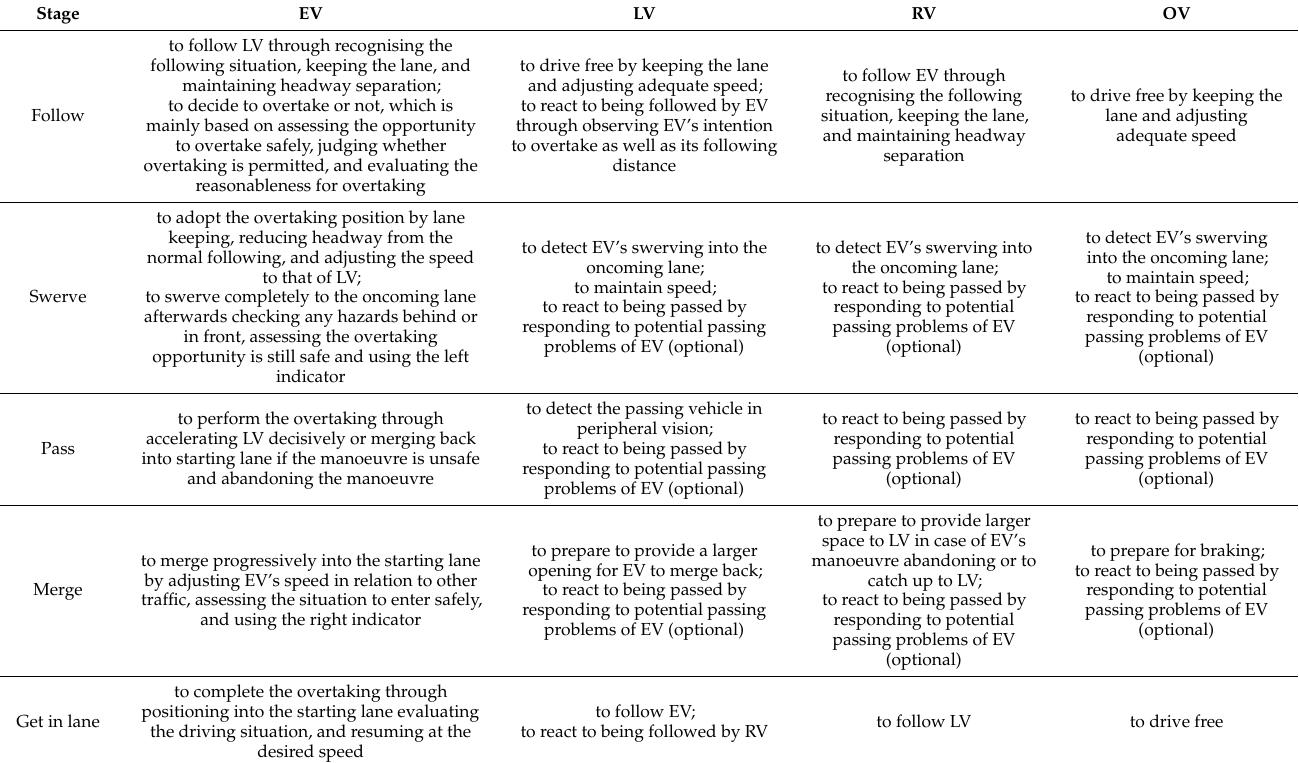
Table A3. A rough description of the main functions of the overall FRAM model per each agent and